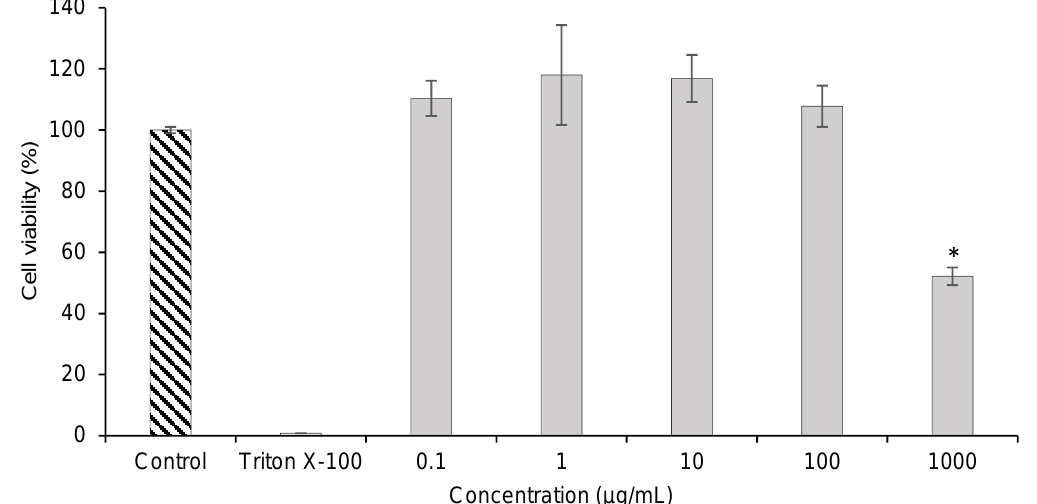
Figure 3. Effect of different concentrations of TR extract on the metabolic activity of HFF-1 cells, measured by the MTT assay. Values were expressed as mean ± SD ( n = 4). * means significant differences ( p < 0.05).